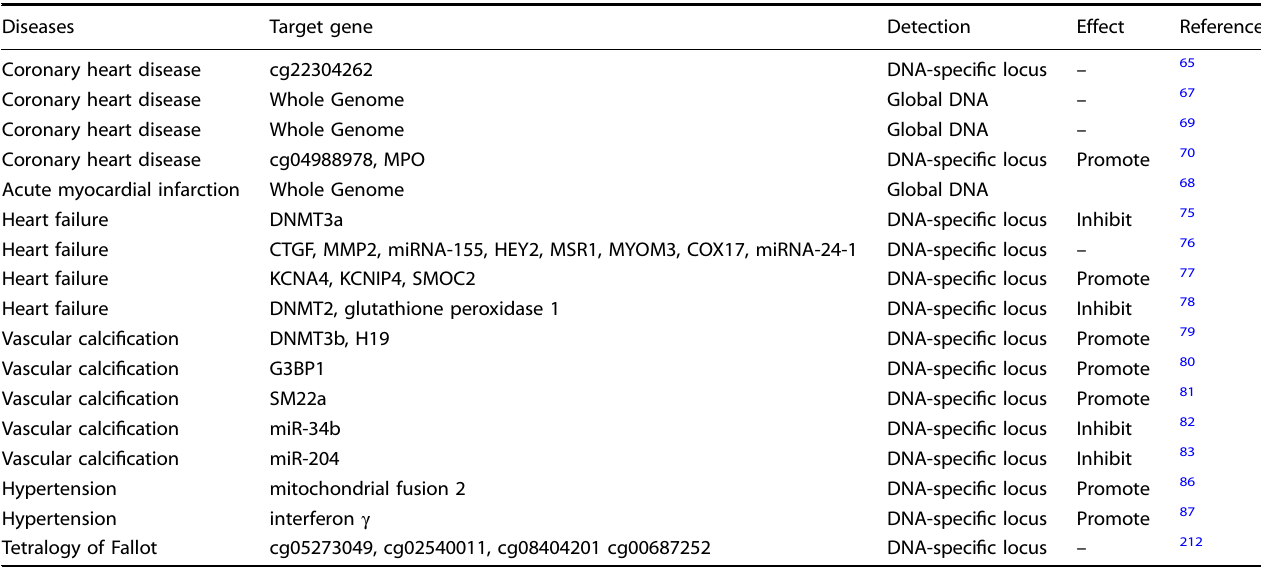
Table 2. Regulation of DNA methylation in cardiovascular disease